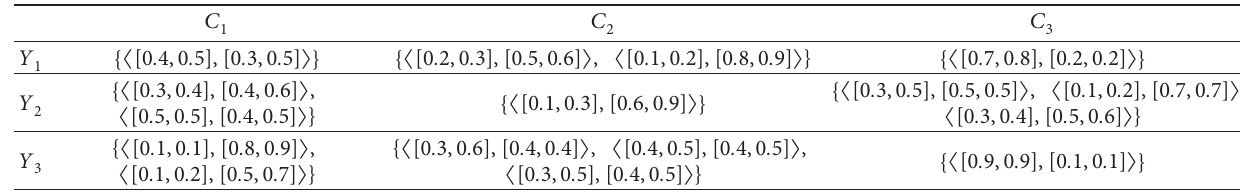
Table 6: IVPHFDM N ( 3 ) .